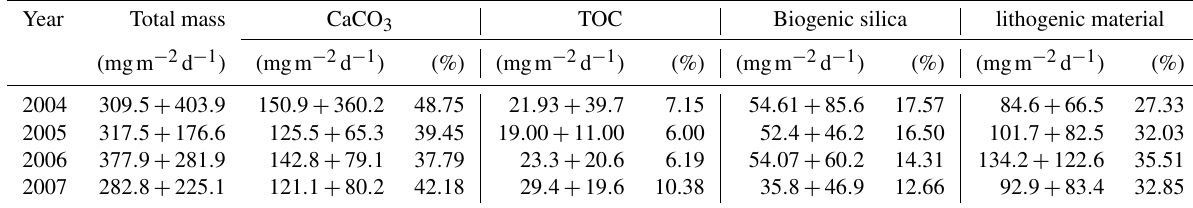
Table 3. Average daily fluxes of total mass, calcium carbonate (CaCO 3 ), total organic carbon (TOC), biogenic silica and lithogenic